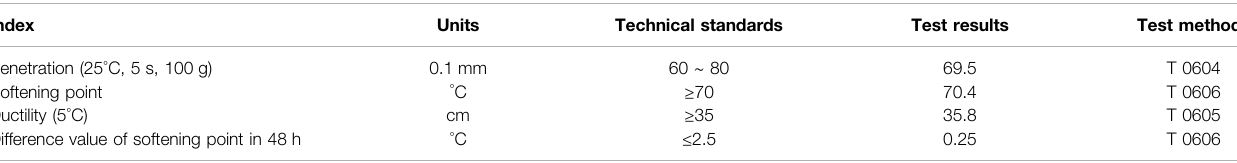
TABLE 2 | The technical performance indexes of SBS modi fi ed